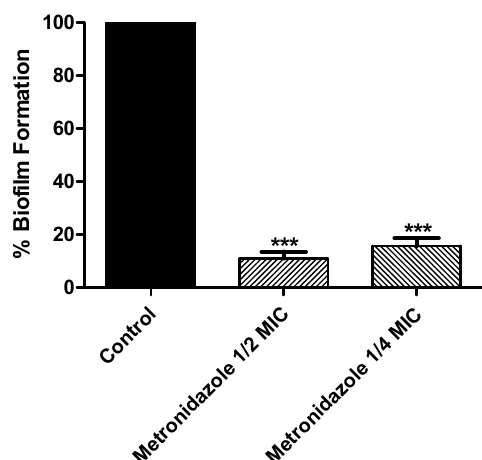
10 of 16 Figure 4. Effect of metronidazole in sub-MIC on P. mirabilis adhesion. ( A ) Adhesion to epithelial cells: epithelial cells from urine of pregnant were cocultured with P. mirabilis treated or untreated with metro- nidazole in ½ MIC or ¼ MIC. ( B ) Metronidazole significantly reduced the number of adhered bacterial cells to epithelial cells ( p < 0.0001 and 0.0095 for ½ MIC or ¼ MIC, respectively). ( C ) Adhesion to abiotic surface: P. mirabilis was cultured in presence or absence of metronidazole in ½ MIC or ¼ MIC, incu- bated at 37 °C for 60 min. The adhered cells were crystal violet stained and their optical densities were measured at 590 nm. Significantly, metronidazole reduced the bacterial adhesion ( p < 0.0001). One-way ANOVA test was used to compare between the metronidazole in ½ MIC or ¼ MIC treated and un- treated bacterial cultures. The data were expressed as mean ± standard error of percentage change from untreated cultures; and were considered statistically significant when p values < 0.05. ( D ) Interactions of metronidazole into the active site of P. mirabilis adhesin MrpH (PDB: ID 6Y4F): ( i , ii ) three dimensional and ( iii ) two dimensional interactions. ** = p < 0.01, *** = p < 0.001. 3.6. Effect of Metronidazole in Sub-MIC on Biofilm Formation To evaluate the biofilm production, P. mirabilis was considerd according [34] as strong biofim forming when OD > 4× ODc (OD = 0.34 and OD = 0.064). The MBECs were